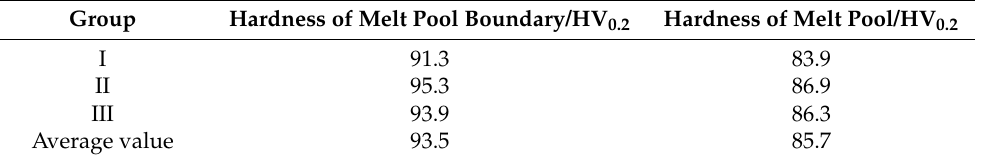
Table 5. Hardness test results of annealed state.